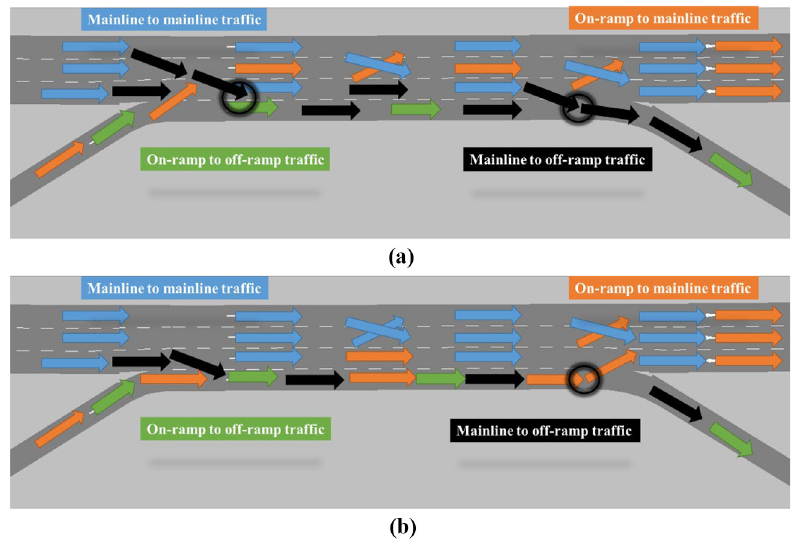
Figure 5 Irregular lane-changing behavior in the weaving